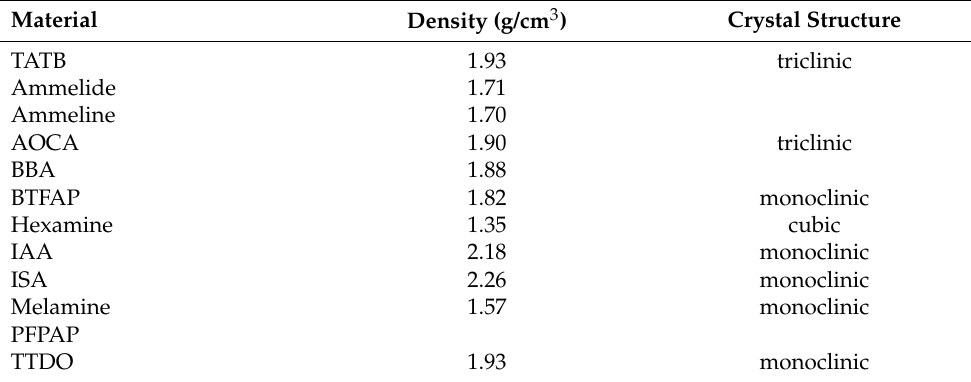
Table 1. Physical property values for TATB and each material initially under consideration as a thermomechanical TATB mock.